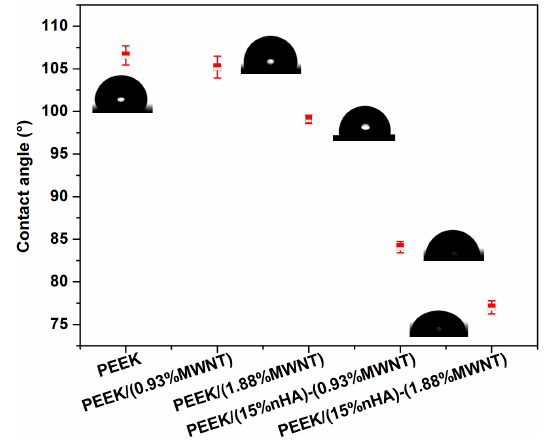
Figure 6. Contact angles formed by spreading of water droplets on PEEK and its nanocomposites.